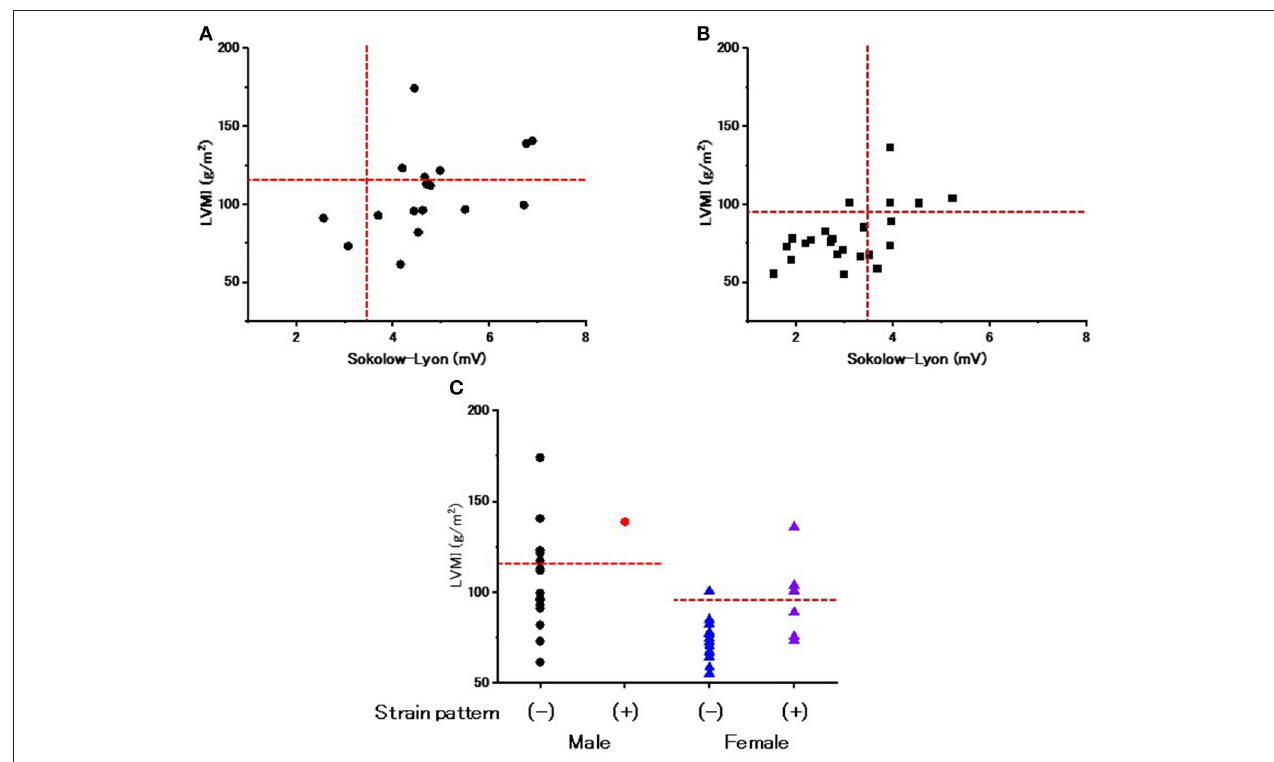
FIGURE 2 | The evaluation of left ventricular hypertrophy and repolarization abnormality on ECGs at the start of enzyme replacement therapy. (A) The relationship between the Sokolow-Lyon index and left ventricular mass index (LVMI) evaluated by echocardiography in male patients at the start of enzyme replacement therapy. Horizontal dotted lines indicate the cut-off value of left ventricular hypertrophy by echocardiography. Vertical dotted lines indicate the cut-off value of left ventricular hypertrophy by the Sokolow-Lyon index. (B) The relationship between the Sokolow-Lyon index and LVMI evaluated by echocardiography in female patients at the start of enzyme replacement therapy. Horizontal dotted lines indicate the cut-off value of left ventricular hypertrophy by echocardiography. Vertical dotted lines indicate the cut-off value of left ventricular hypertrophy by the Sokolow-Lyon index. (C) The LVMI with and without a strain pattern. Dotted lines indicate the cut-off value to determine left ventricular hypertrophy. Closed black circles indicate the male patients without a strain pattern. Closed red circles indicate the male patients with a strain pattern. Blue triangles indicate the female patients without a strain pattern. Purple triangles indicate the female patients with a strain